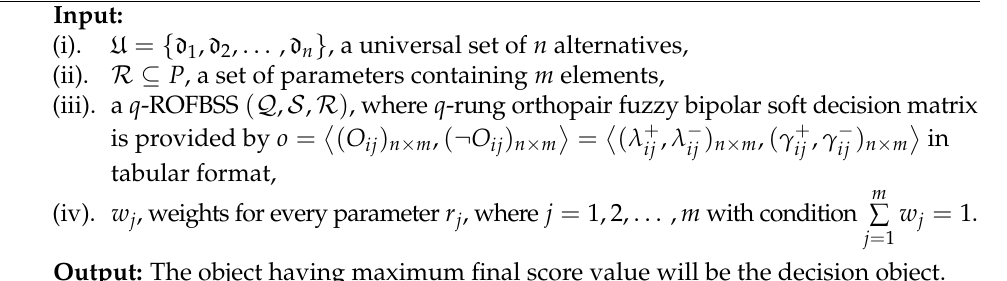
Algorithm 1: Selection of a suitable object using q